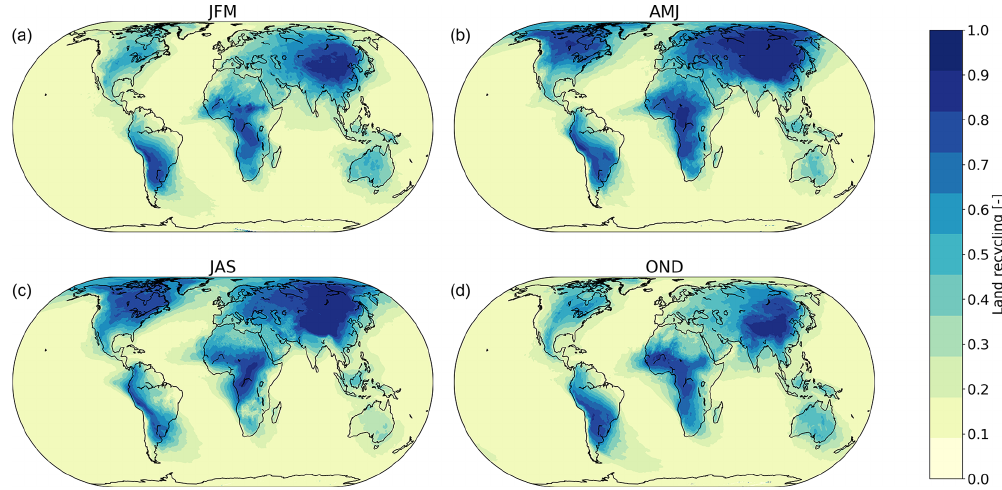
Figure 4. Seasonal variability of precipitation recycling ratio over land. Precipitation recycling ratio is the fraction of precipitation that has evaporated from land. (a) January through March. (b) April through June. (c) July through September. (d) October through December.